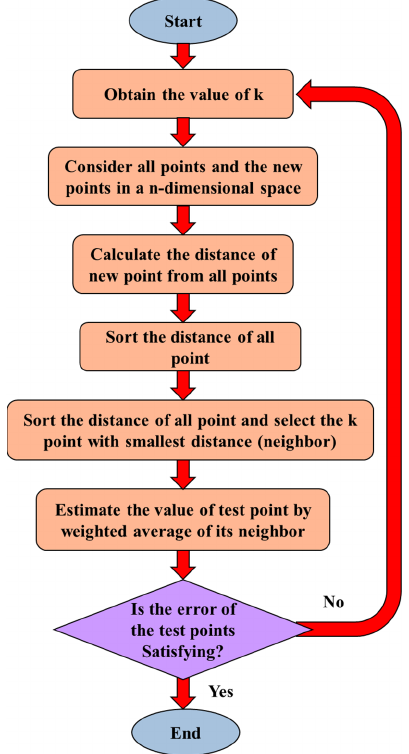
Figure 14. Flowchart of the k-NN algorithm.